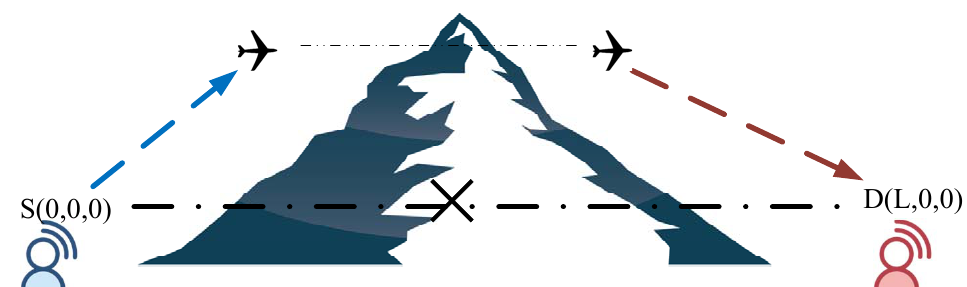
Figure 1. UAV-enabled communication system with mountain